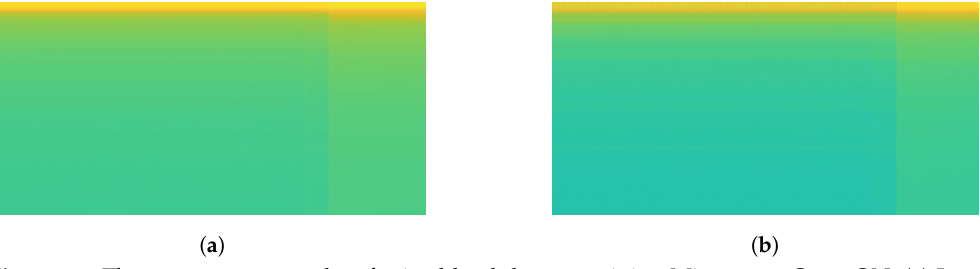
Figure 21. The spectrogram results of mixed load data containing Microwave Oven ON: ( a ) Load Combination of Oil Heater Power-2, Fume Extractor, and Microwave Oven ON; ( b ) Load Combination of LED Panel, Hair Dryer Parlux, and Microwave Oven